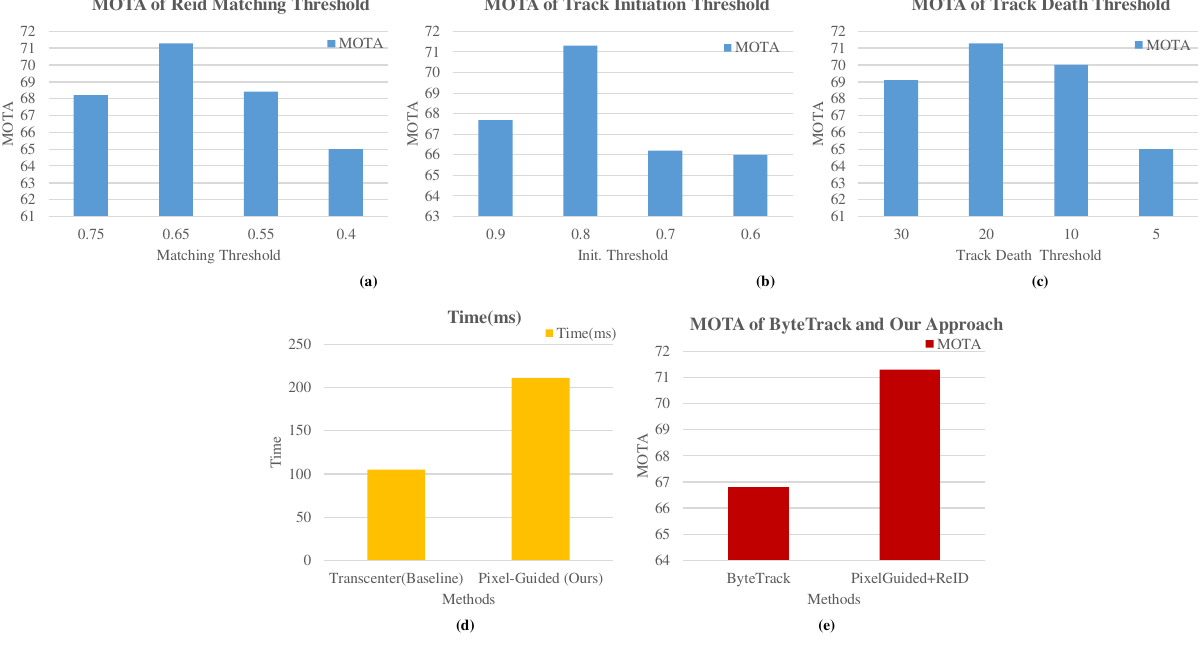
Figure 4. Effectiveness of our method on the MOT17 Training dataset: ( a ) MOTA of matching thresholds in Reid function; ( b ) effective track initiation thresholds on MOTA; ( c ) effective track death thresholds on MOTA; ( d ) average inference time; ( e ) effectiveness of Reid